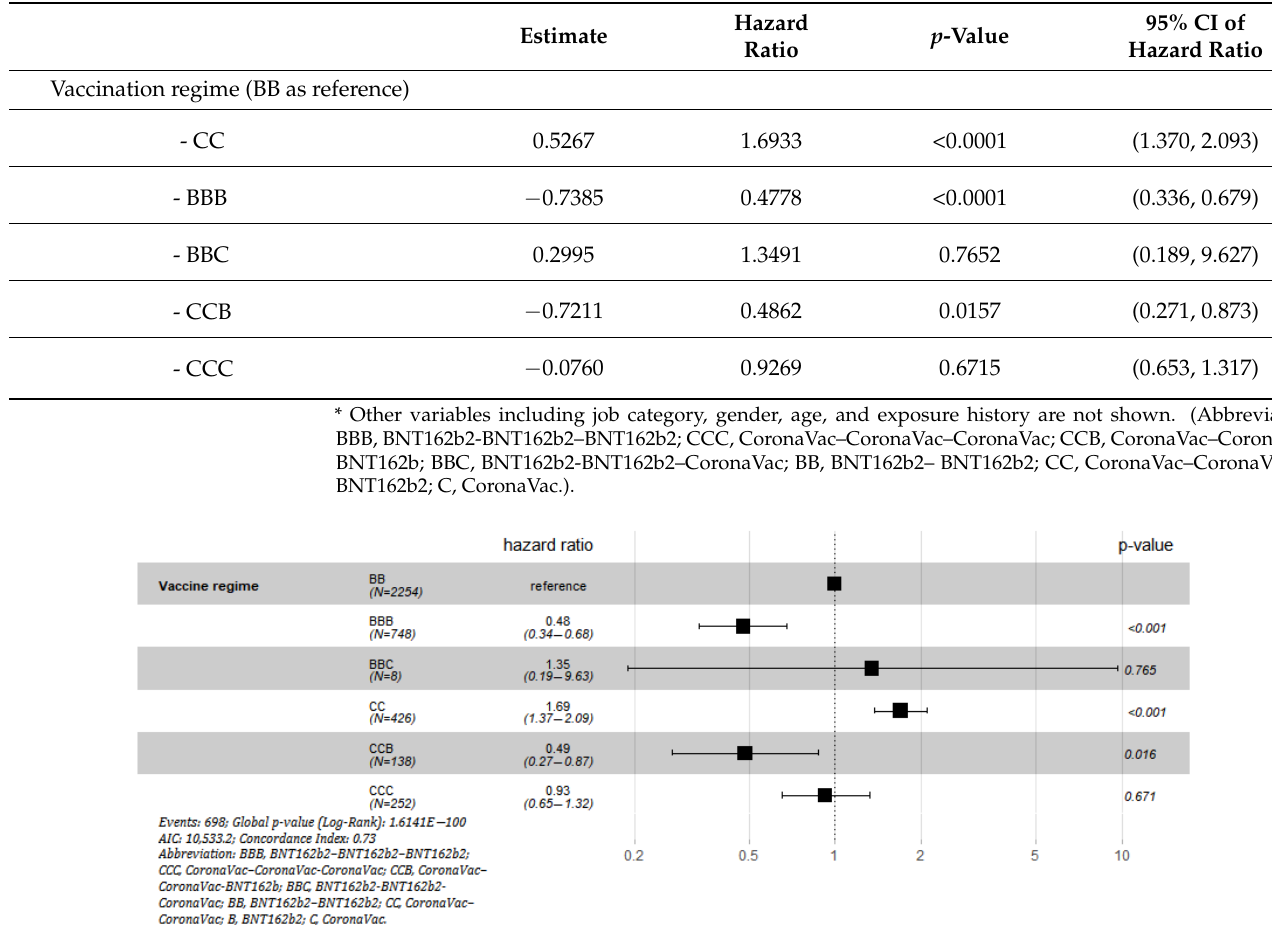
regime using 2-dose BNT162b2 as reference. (Abbreviation: BBB, BNT162b2–BNT162b2–BNT162b2;